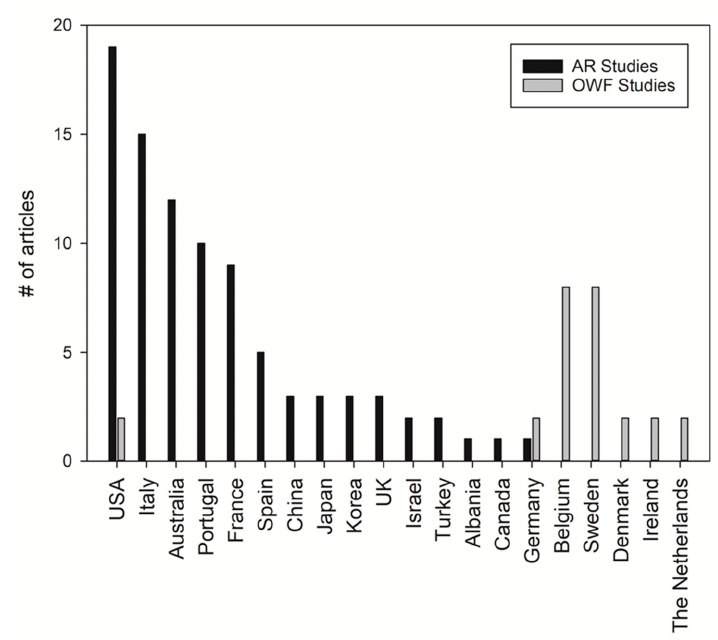
Figure 4. Number of artificial reef (AR) and offshore wind farm (OWF) studies per country throughout the years 1982–2018 (source: Web of Science, Scopus).